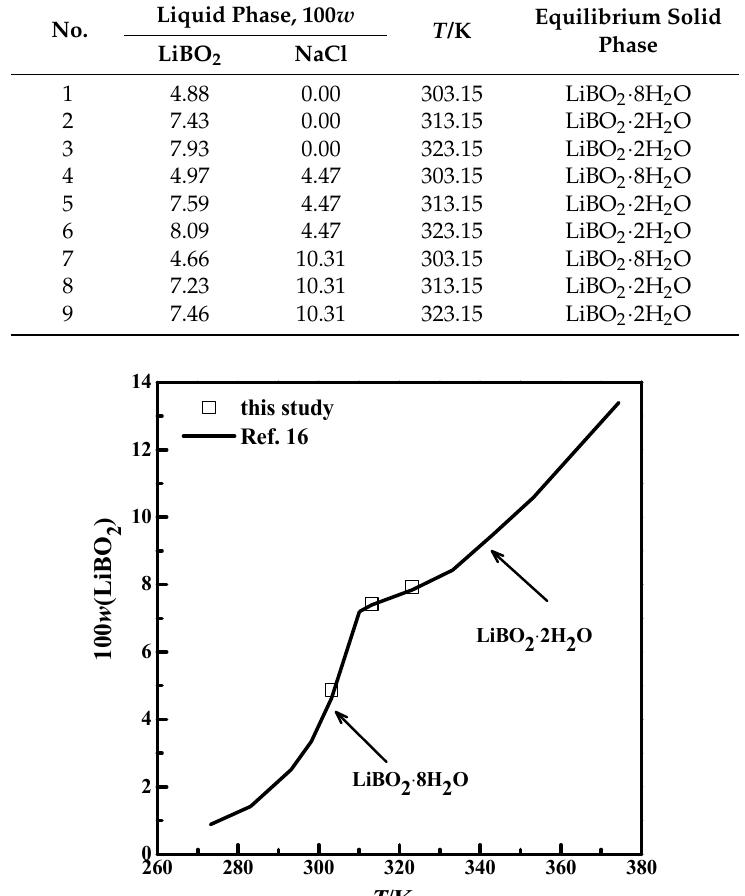
Table 1. Experimental solubility data in the systems LiBO 2 − H 2 O and LiBO 2 − NaCl − H 2 O. Liquid Phase, 100 w No.